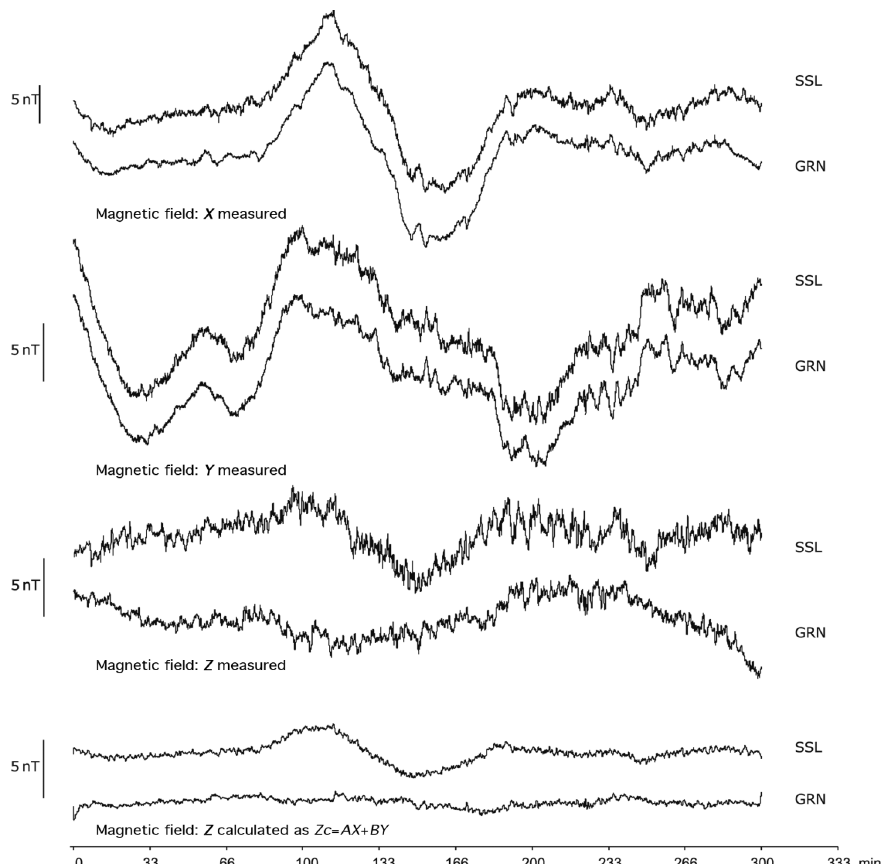
Fig. 4. Example of recorded and calculated (vertical component) magnetic signal at SSL and GRN. Recorded data starts at April, 14th 2005 UT